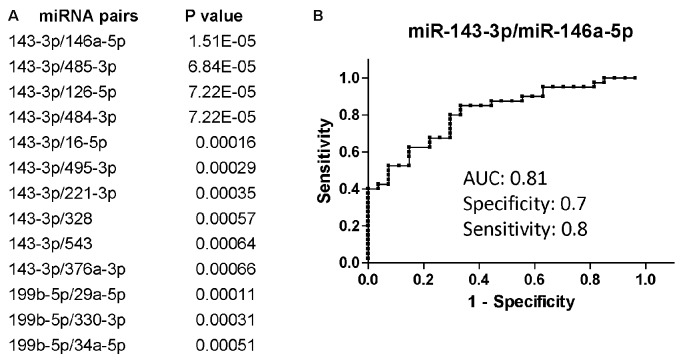
Differentially regulated miRNAs and miRNA pairs in persons living with HIV-1/AIDS (PLWHA) with alcohol use disorder (AUD) at LSU Health Sciences Center (LSUHSC). (A) miRNA pairs discriminating subjects with AUD (n = 27) and without AUD (n = 39). (B) Receiver Operator Characteristic (ROC) curve for the miRNA pair that best associated with AUD. AUC, area under the curve.